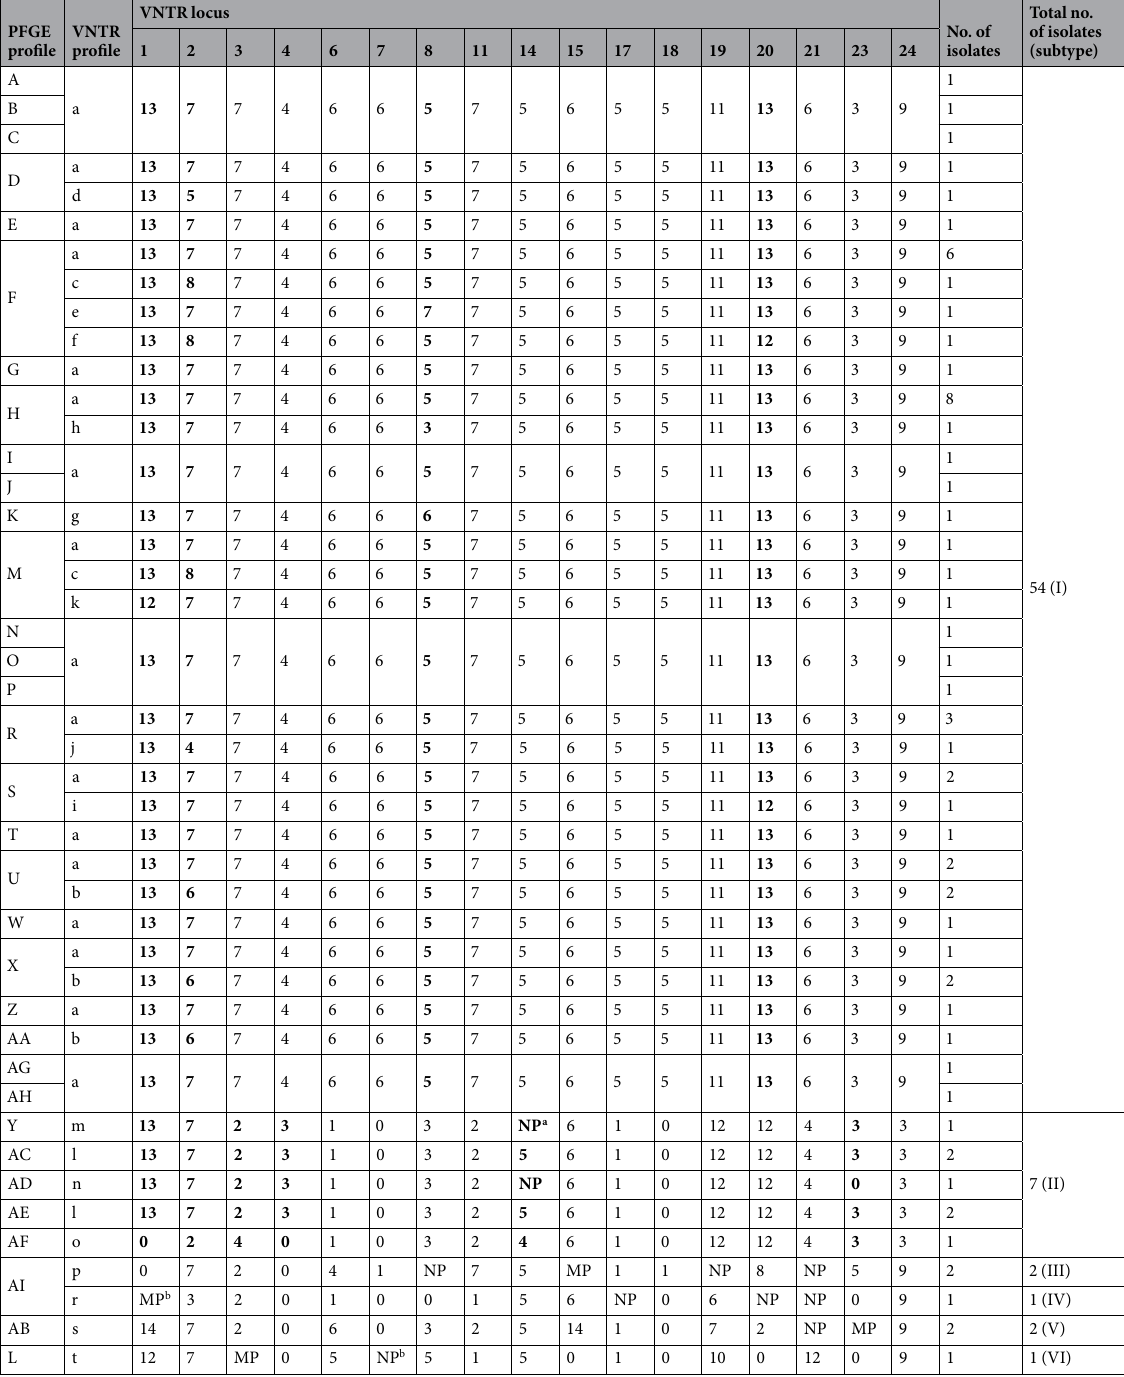
Table 3. Combined analysis of VNTR and PFGE profiling results of 67 M. kansasii isolates. Bold font indicates VNTR locus at which allelic variability within the same subtype was observed; a NP, no PCR product; b MP, multiple-band